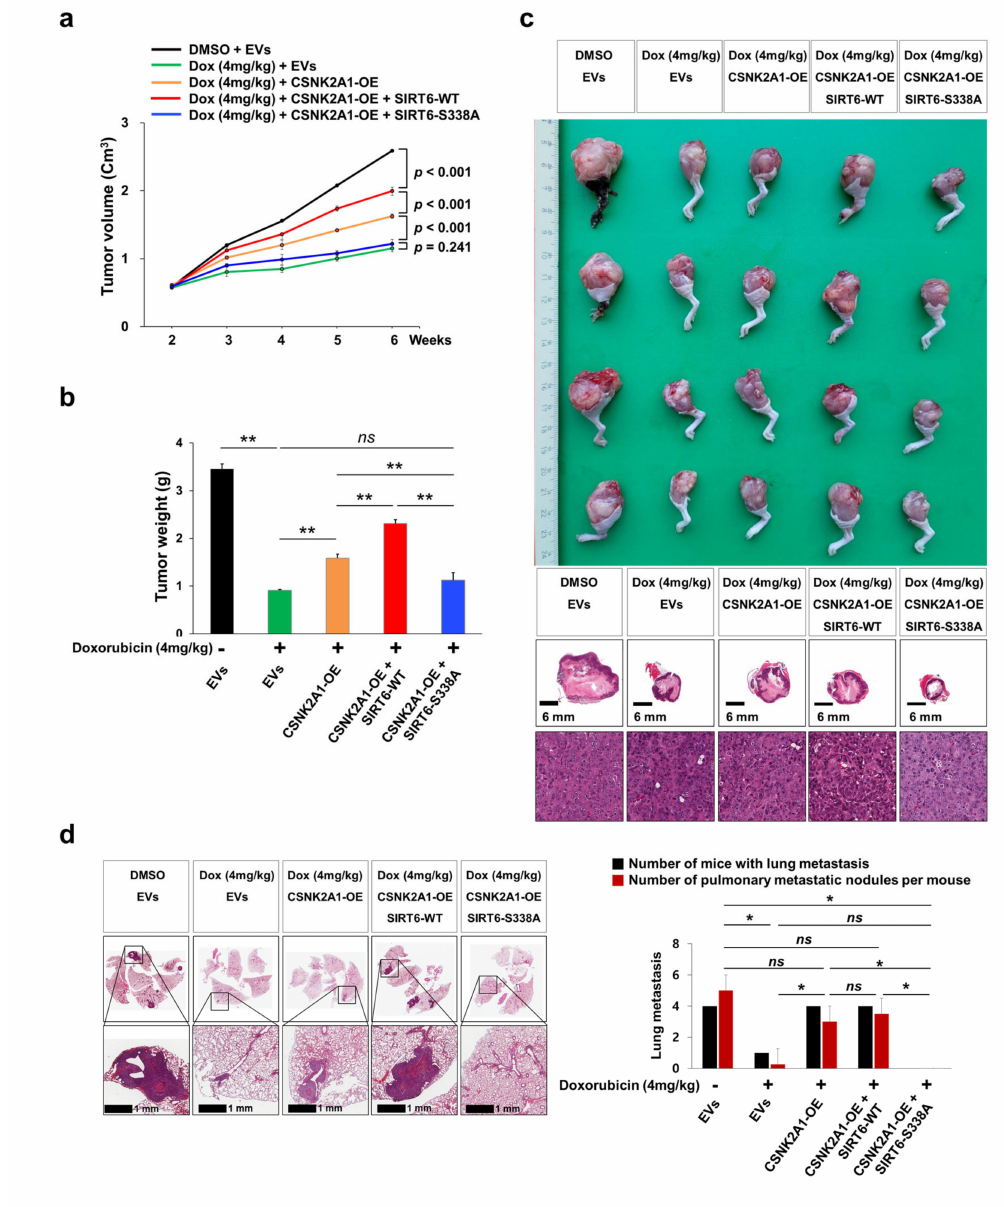
Figure 8. CSNK2A1-mediated resistance to doxorubicin in osteosarcoma cells is attenuated by the mutation of SIRT6 in vivo. ( a ) KHOS/NP (2 × 10 6 ) cells were transfected with empty vectors (EVs), WT-CSNK2A1, WT-CSNK2A1, and WT-SIRT6 (SIRT6-WT; pFLAG2_SIRT6) or WT-CSNK2A1 and mutant SIRT6 (pSIRT6-S338A; pFLAG2_SIRT6_S338A) and injected into the bone marrow of the proximal tibia under anesthesia. Two weeks after tumor implantation, doxorubicin (4 mg/kg in DMSO) was injected intraperitoneally once a week, and the volume of the tumor was measured every week. The tumor volumes were calculated as length × width × height × 0.52. ( b ) Six weeks after tumor injection, tumor weight was measured after the euthanization of mice. ( c ) Macroscopic and microscopic images of orthotopic xenografted tumors. ( d ) Microscopic findings of pulmonary metastatic nodules at six weeks after the injection of KHOS/NP cells. The data for the number of mice with pulmonary metastasis and the number of pulmonary metastatic nodules per mouse is presented as a graph. The number of metastatic nodules was counted under microscopy. ns ; not significant, *; p < 0.05, **; p <